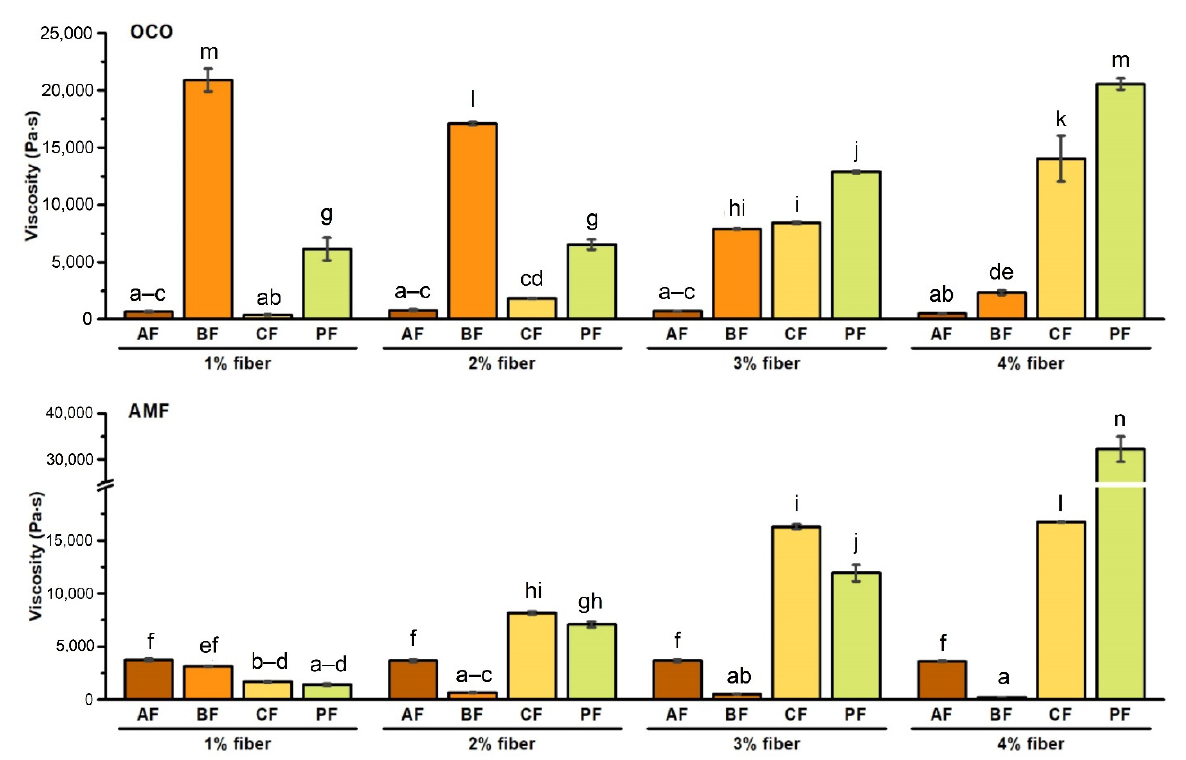
Figure 3. Effect of fiber type and concentration on viscosity of PCS (processed cheese sauces) obtained on the basis of AC (acid casein) and WPC80 (whey protein concentate) with OCO (organic coconut oil) or AMF (anhydrous milk fat) ( p < 0.05). Letters (a–n) indicate significant differences at p < 0.05.